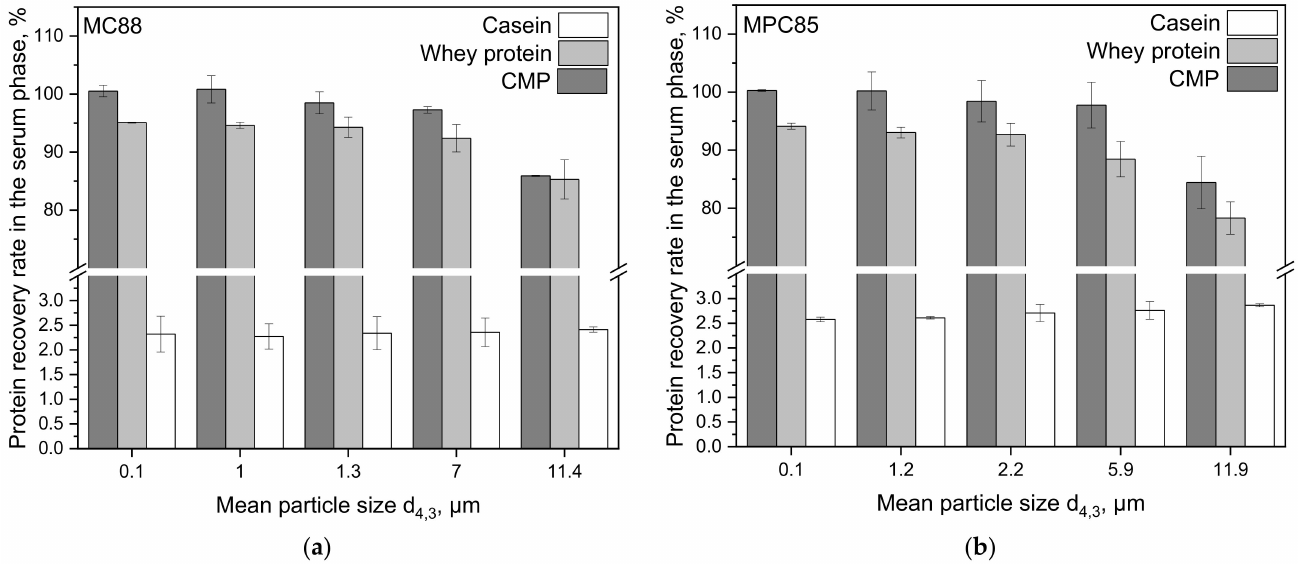
Figure 5. Casein, whey protein, and casein macropeptide (CMP) recovery in the serum phase after incubation (t = 1 h, ϑ = 40 ◦ C) and centrifugation at 4000 × g (t = 45 min, ϑ = 20 ◦ C) of skim milk enriched with MC88 ( a ) and MPC85 ( b ) plotted for each mean particle size d 4,3